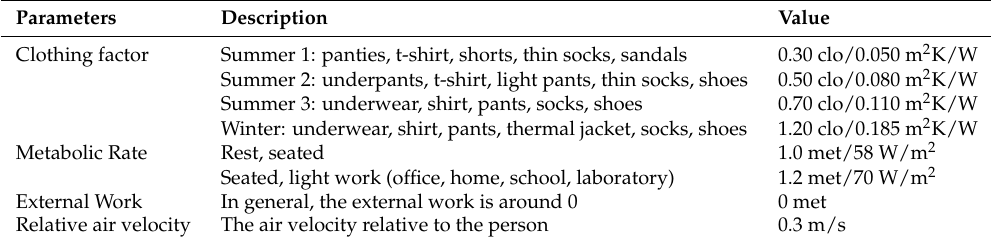
Table 5. Input data of comfort in the two buildings, according to ISO